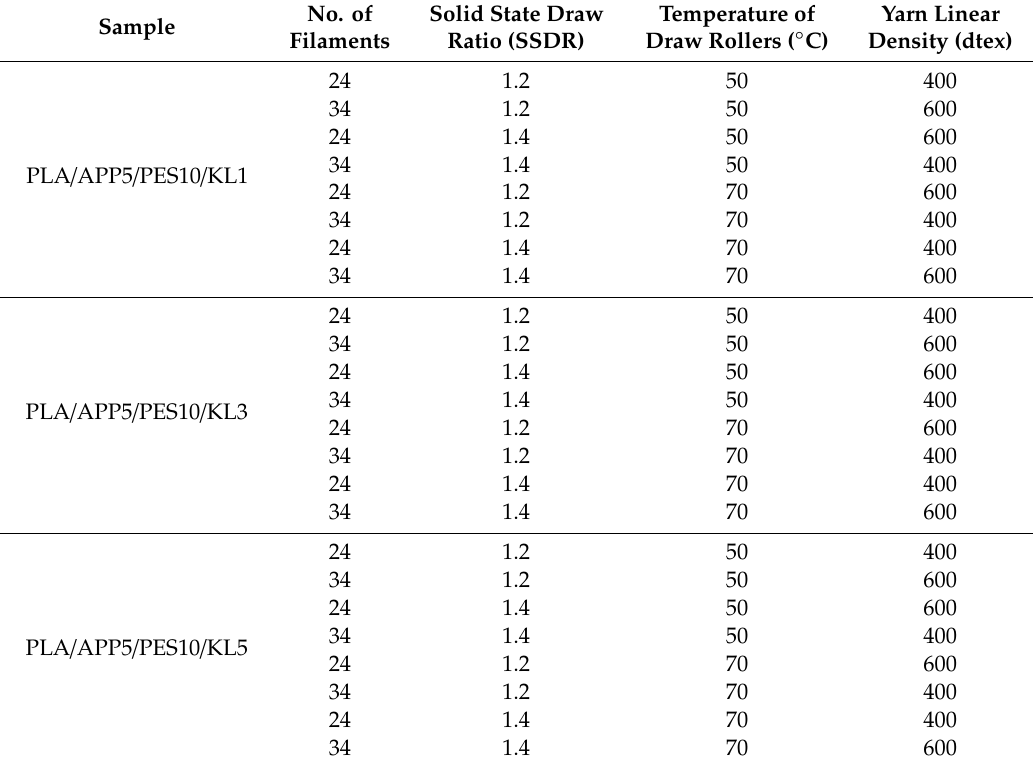
Table 4. Design of the